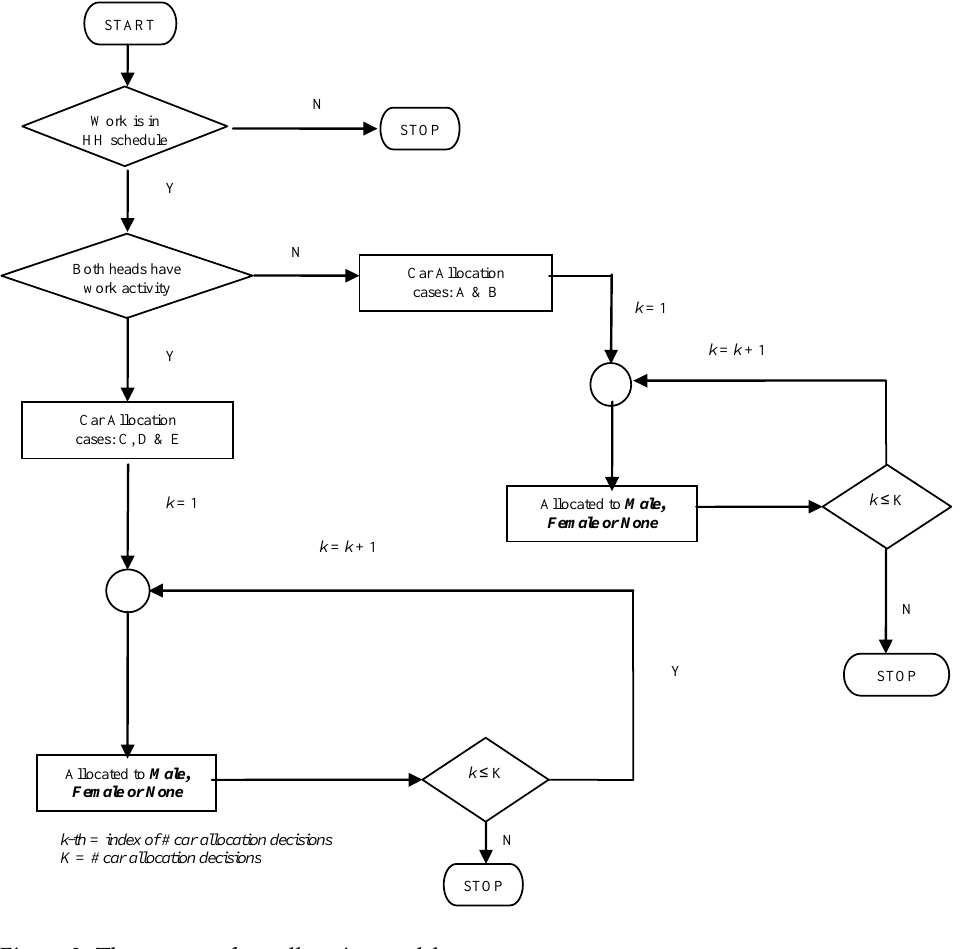
Figure 2. The process of car allocation